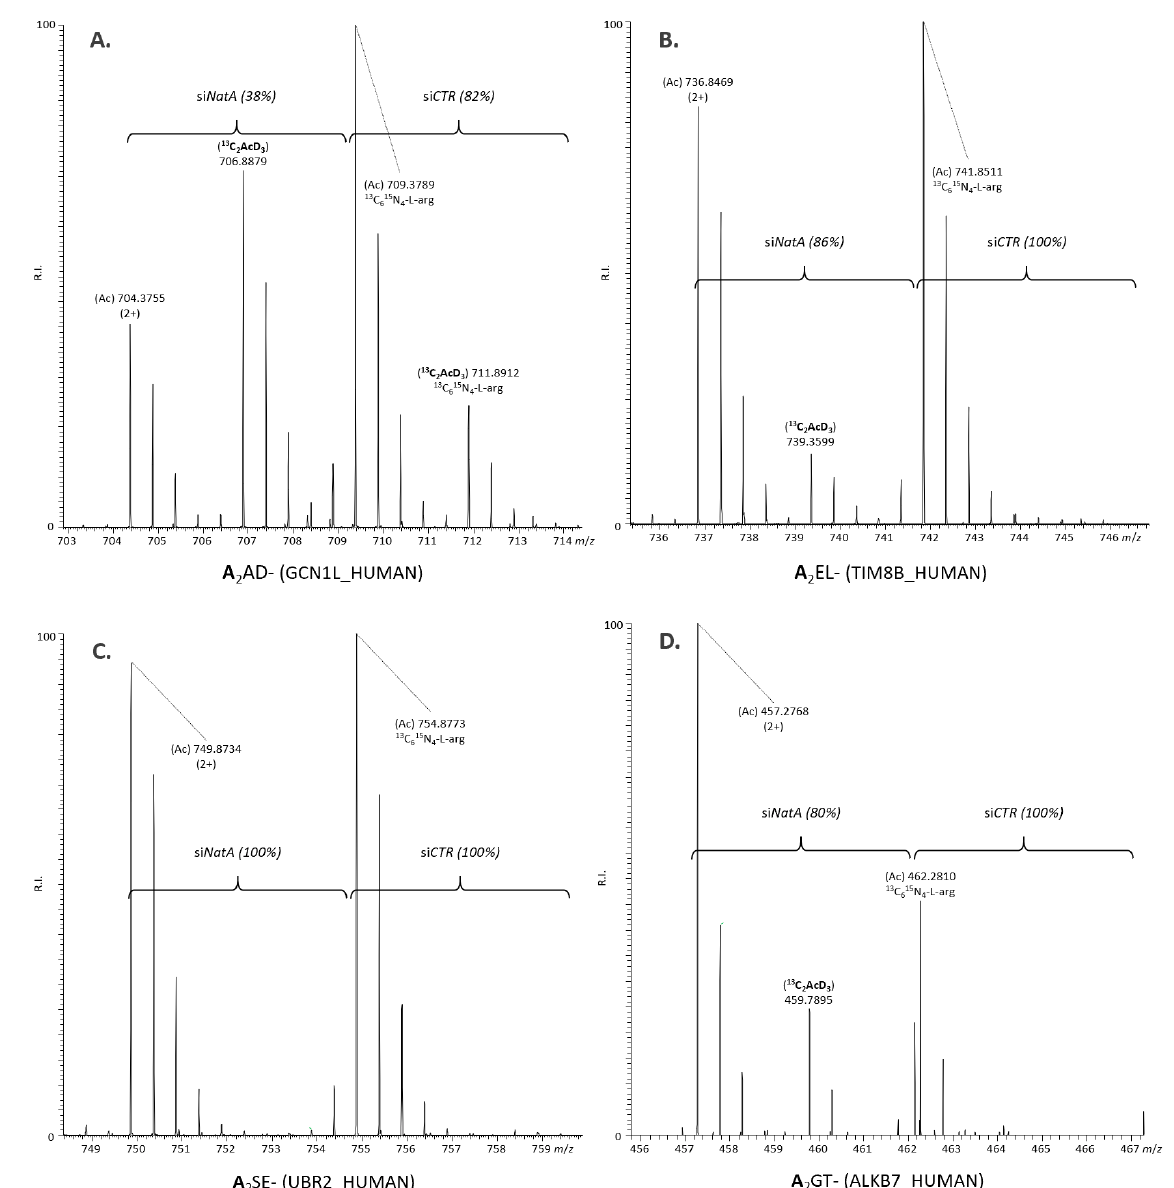
Figure 4. The effect of si NatA knockdown on representative Ala- starting NatA substrate N-termini. ( A ) An MS spectrum of the N-terminus originating from the previously confirmed NatA substrate [2,32,37], being the translational activator GCN1 ( 2 AADTQVSETLKR 13 ) is shown. The peptide was partially NTA in both control (si CTR ) (82%) and si NatA knockdown (38%) samples. ( B ) MS spectrum of the N-terminus originating from mitochondrial import inner membrane translocase subunit Tim8 B ( 2 AELGEADEAELQR 14 ). The peptide was fully NTA in the control setup while being only partially NTA (86%) in the si NatA knockdown sample. ( C ) MS spectrum of the N-terminus originating from the E3 ubiquitin-protein ligase UBR2 ( 2 ASELEPEVQAIDR 14 ). The peptide was fully NTA in the control setup and was unaffected (i.e., the N-terminus remained fully NTA) upon si NatA knockdown. The total concentration of the representative Ala- N-termini shown in ( A – C ) all remained unaffected upon si NatA knockdown (ratios of 0.89, 0.98 and 0.93, respectively). ( D ) MS spectrum of the N-terminus originating from the mitochondrial alpha-ketoglutarate-dependent dioxygenase alkB homolog 7 ( 2 AGTGLLALR 10 ). The peptide was fully NTA in the control setup while being only partially NTA (80%) in the siNatA knockdown sample. The expression of this NatA substrate N-terminus was significantly increased (P ≤ 0.01) upon si NatA knockdown (ratio 2.6).